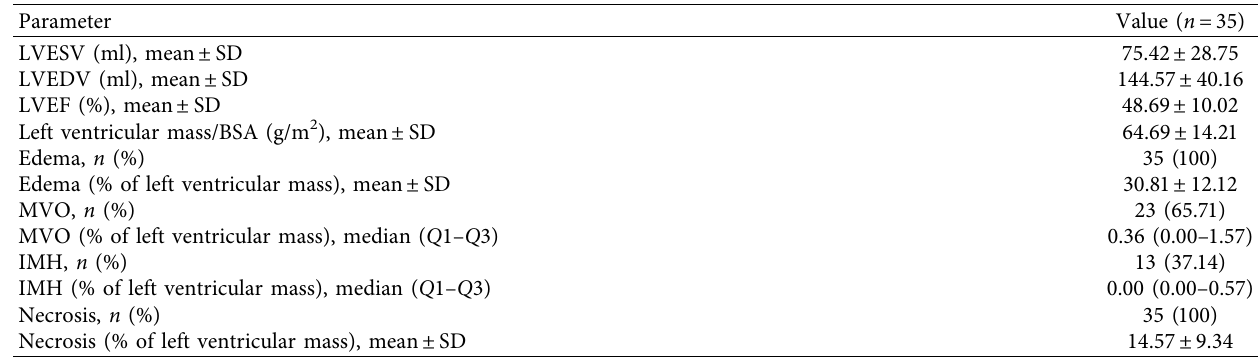
Table 2: CMR characteristics, three to seven days after the index procedure.